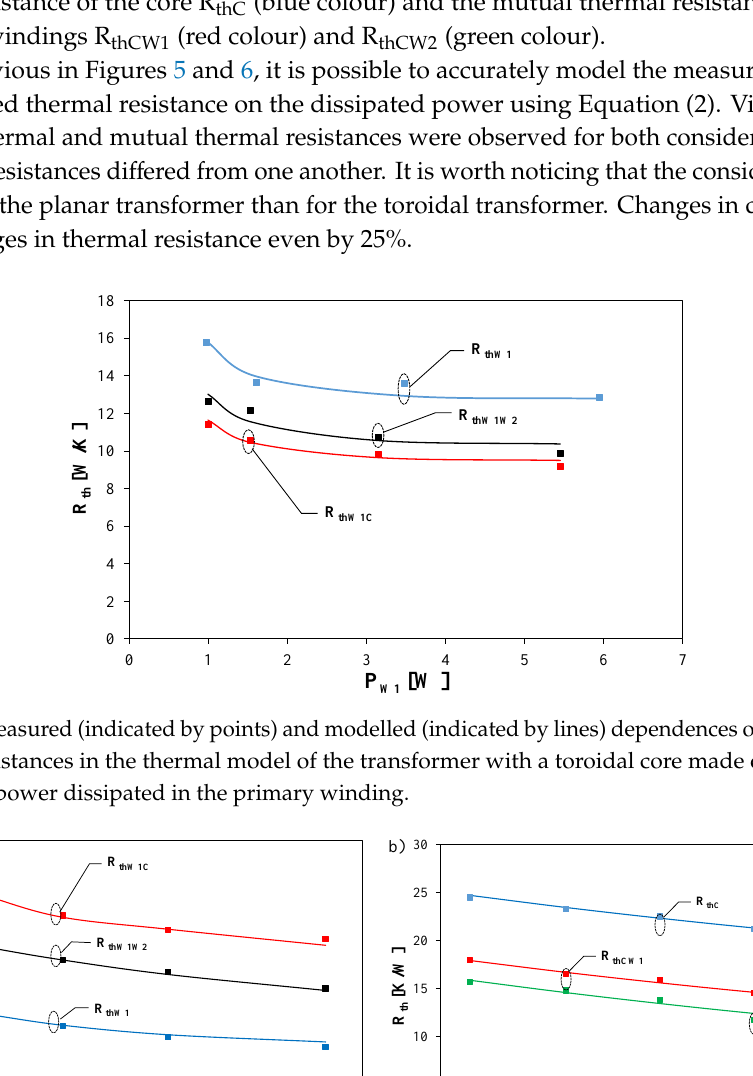
Figure 6. Measured (indicated by points) and modelled (indicated by lines) dependences of the selected thermal resistances in the thermal model of the planar transformer on the power dissipated in the primary winding ( a ) and in the core ( b ).